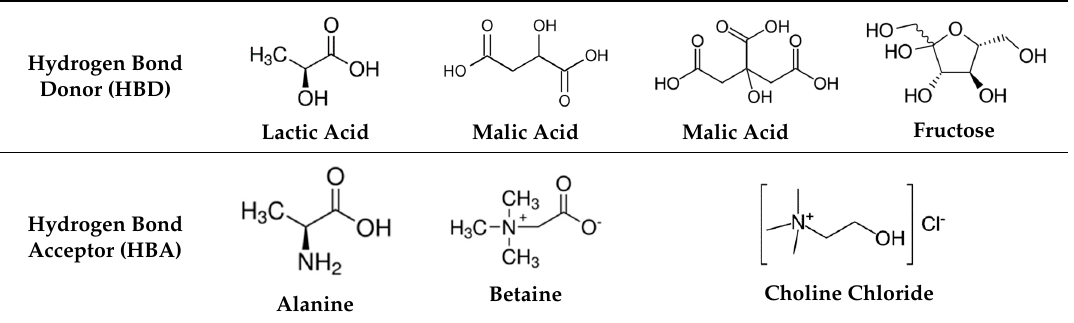
Table 1. Structures of hydrogen bond acceptors (HBA) and hydrogen bond donors (HBD)